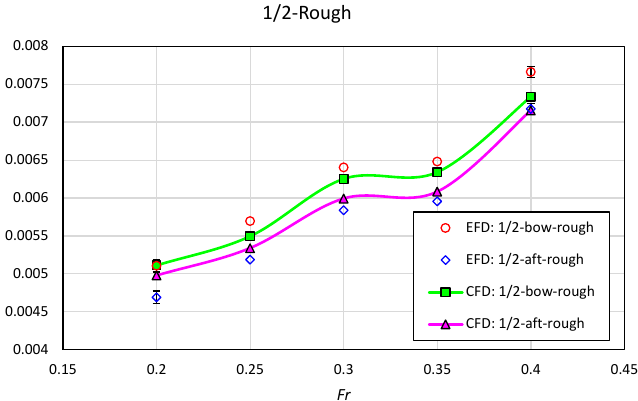
Figure 8. 𝐶 (cid:3021) of the Wigley hull with ¼-bow-rough and ¼-aft-rough conditions obtained from the current CFD simulations and the EFD result [27].